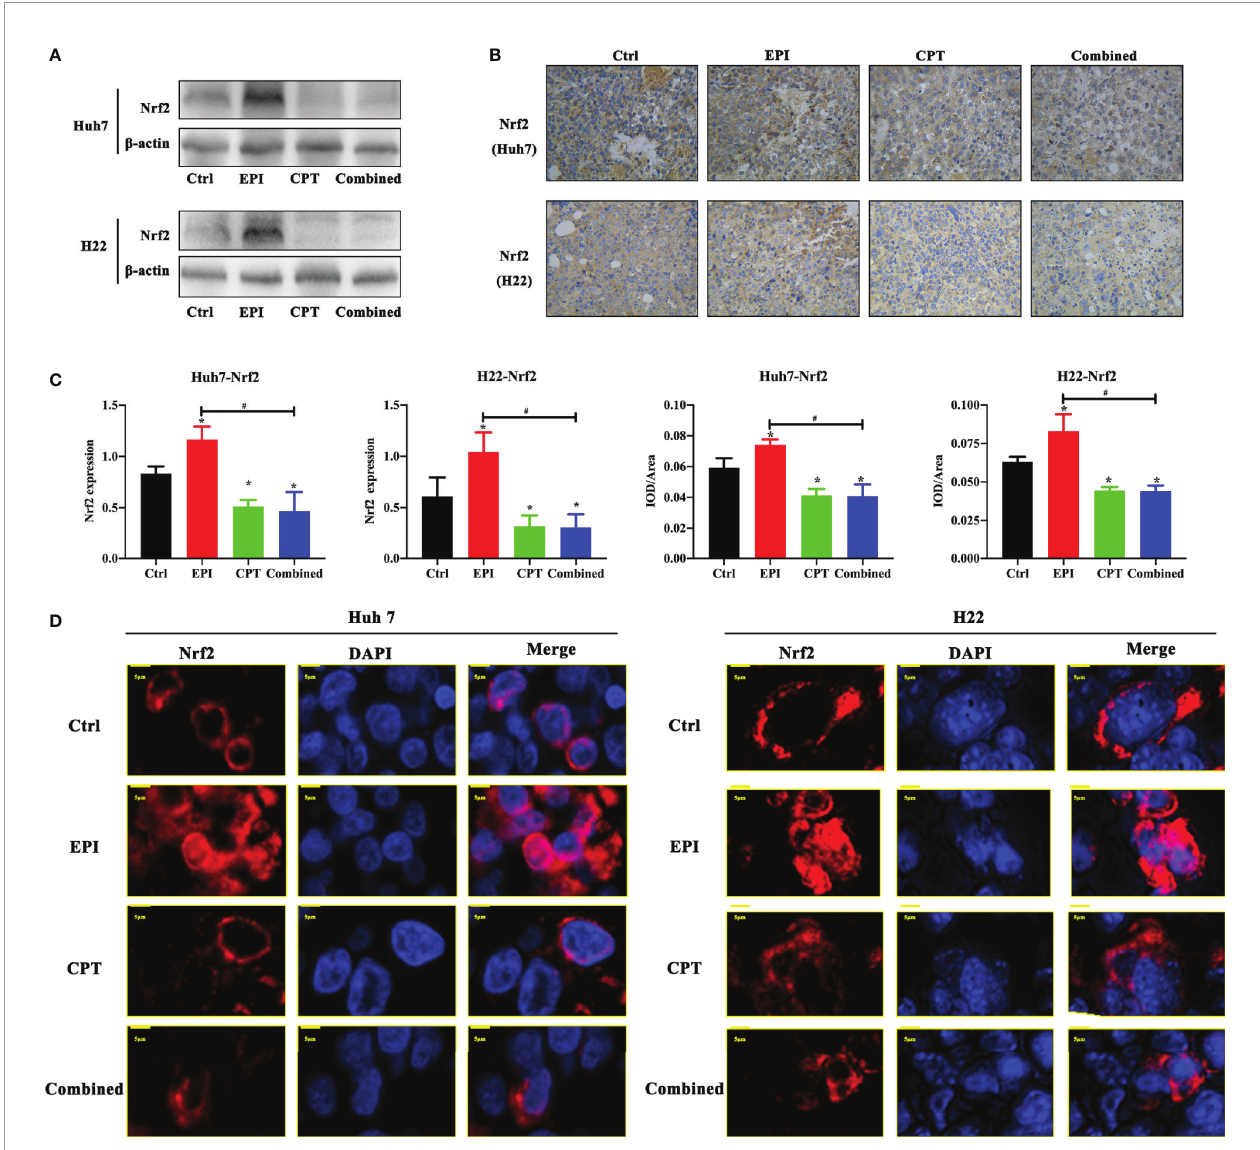
FIGURE 2 | Expression of Nrf2 expression and translocation with EPI and CPT administration in Huh7/H22 tumor cells. The subcutaneous tumors of Huh7 and H22 were separated on 10 days post fi rst injection of EPI and CPT. (A) The Nrf2 expression by western blot. b -actin was the internal control. (B) The Nrf2 expression and assay by IHC staining. (C) The assay of Nrf2 expression. (D) The nucleus translocation of Nrf2 (red) in Huh7 and H22 tumors. DAPI (blue) indicated the nucleus. *P < 0.05, # P <